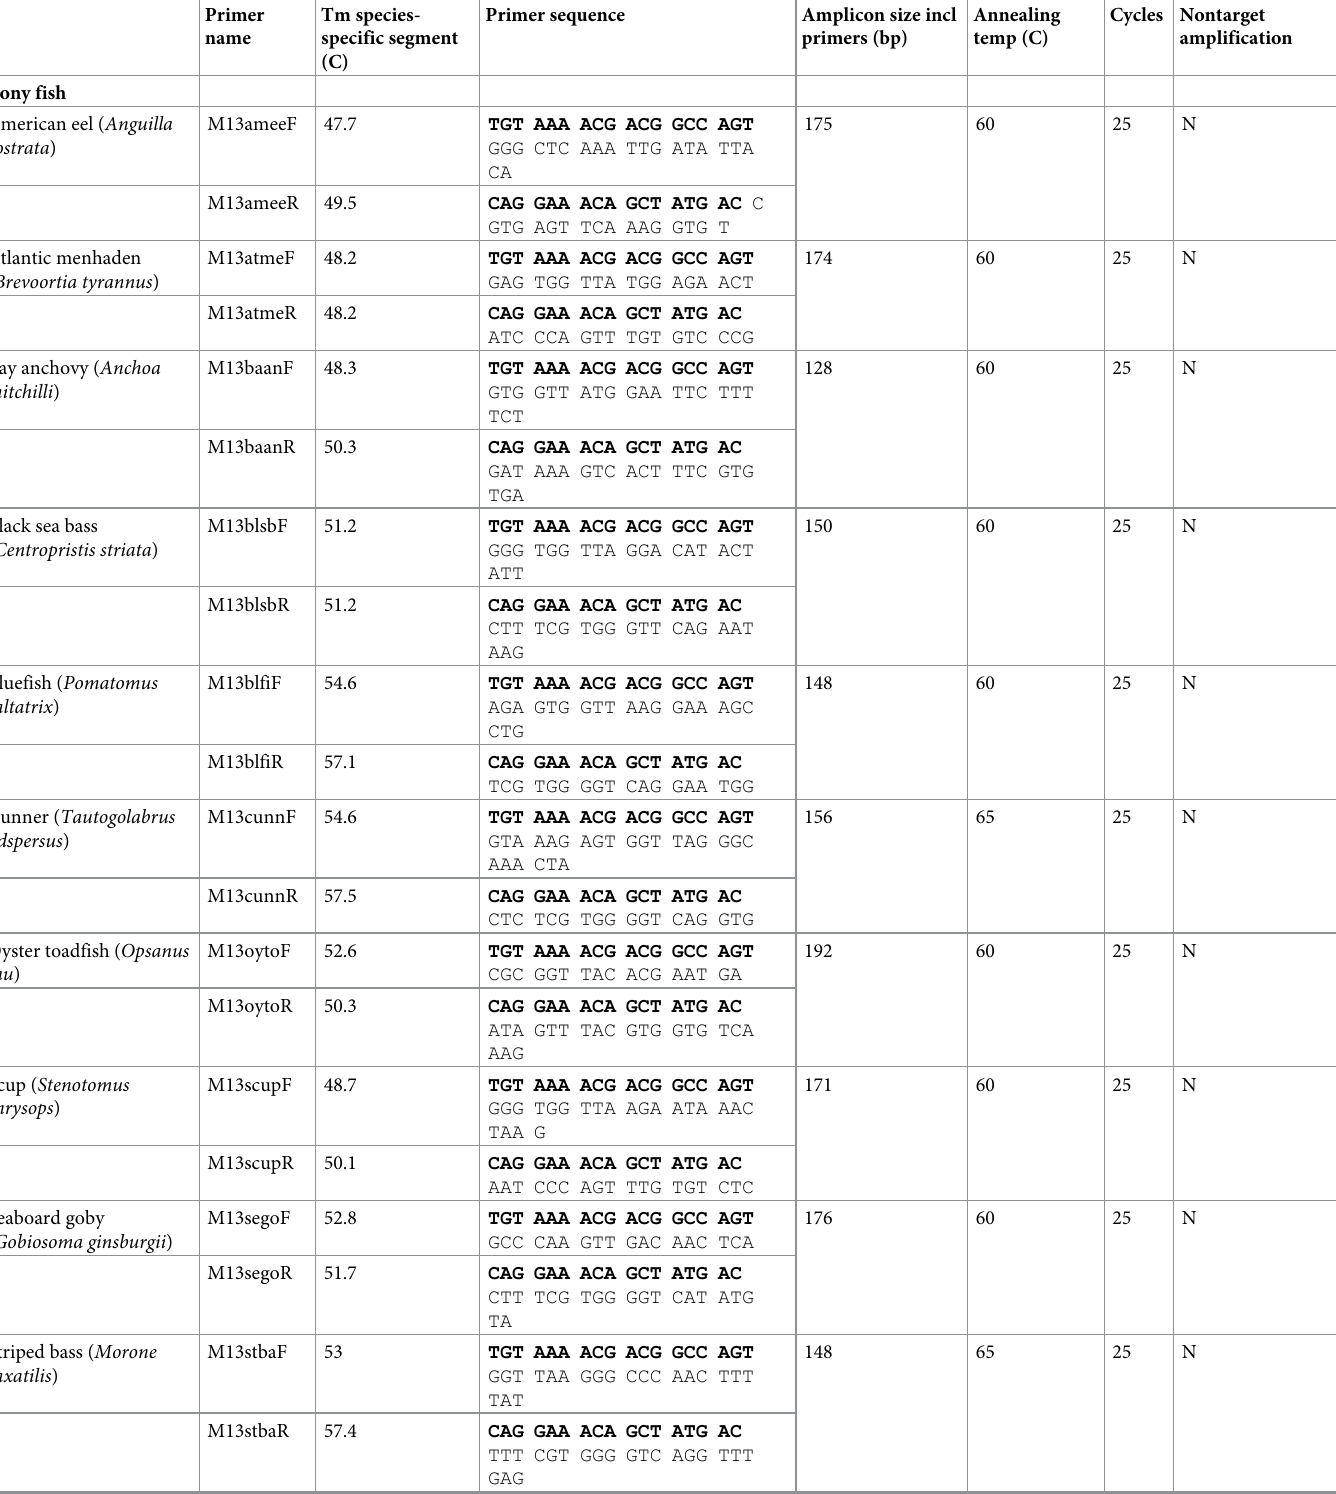
Table 2. Species-specific GoFish primers. Amplicon sizes, PCR parameters, and target specificity as shown. M13 tails are highlighted in bold. All primer sets were newly designed for this